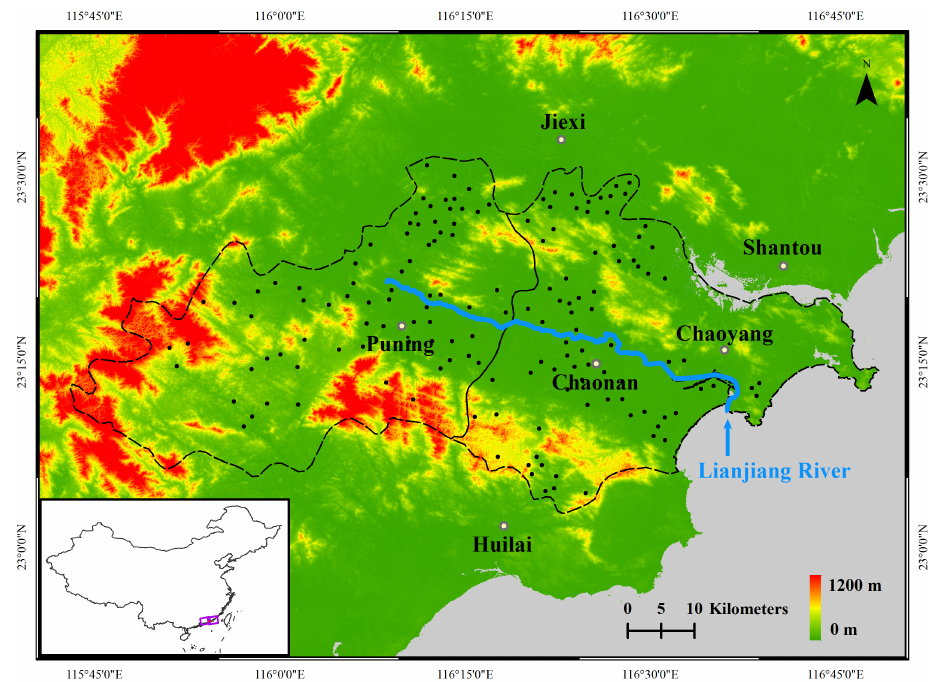
Figure 1. Location of the Lianjiang Plain (LJP). The background is hill-shaded by the ASTER GDEM and the no data region in South China Sea is set to gray. The black dashed polygons represent the administrative division boundaries of Puning, Chaonan, and Chaoyang. The maximum elevation within the boundaries is 967 m. Each black dots represents an ancient village of the Chaoshan Residence in LJP. The lower left gives the administration boundary of China. The purple polygon in the lower inset is the coverage of the two datasets from Sentinel-1A, and the red blob is the coverage of